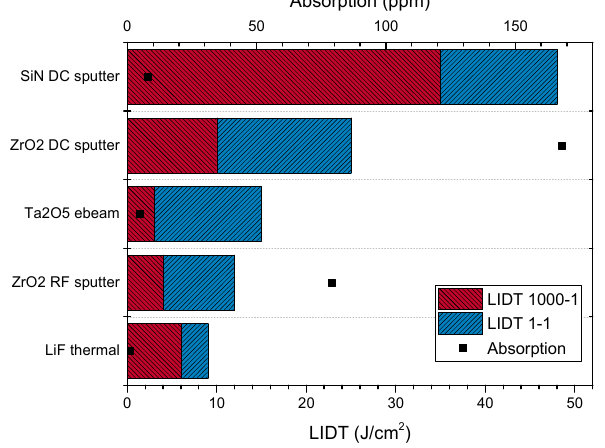
Figure 5. Comparison of 1000 ‐ on ‐ 1 and 1 ‐ on ‐ 1 the laser ‐ induced damage threshold (LIDT) to baseline PCI absorption for the single ‐ layer coatings.